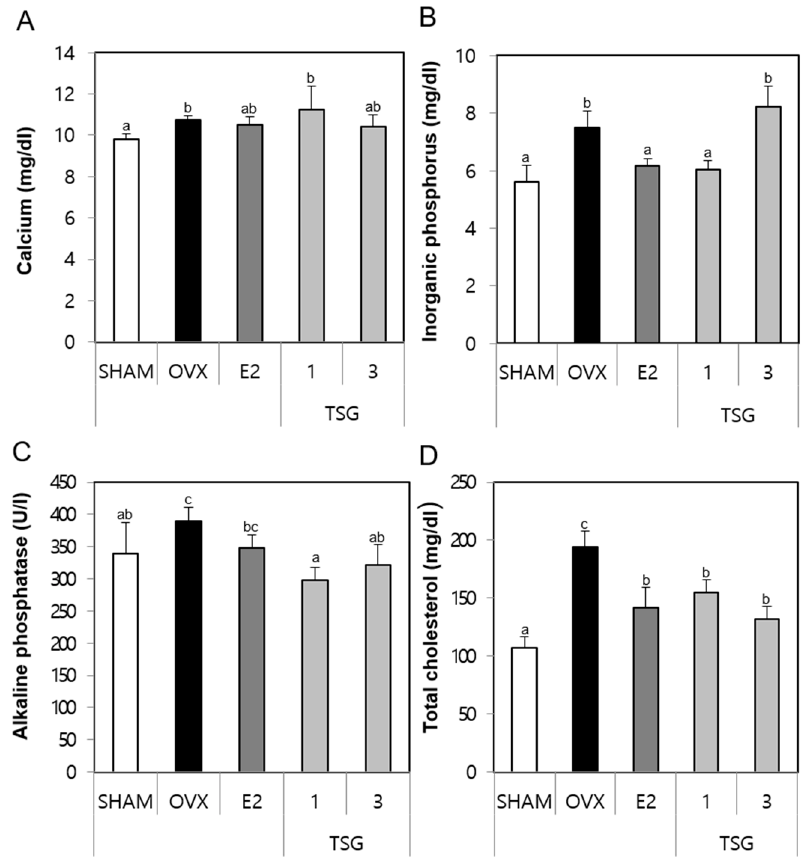
Figure 3. Effect of TSG on the serum biochemical markers. In the control, the SHAM-operated mice and OVX mice with or without the administration of TSG (1 and 3 μ g/g/day, I.P) for six weeks, the serum ( A ) calcium, ( B ) phosphorus, ( C ) alkaline phosphatase, and ( D ) total cholesterol were determined using a diagnostic slide. a, b, and c: The means not sharing a common letter are significantly different among the groups at p < 0.05 by one-way ANOVA with Duncan’s multiple-range test.